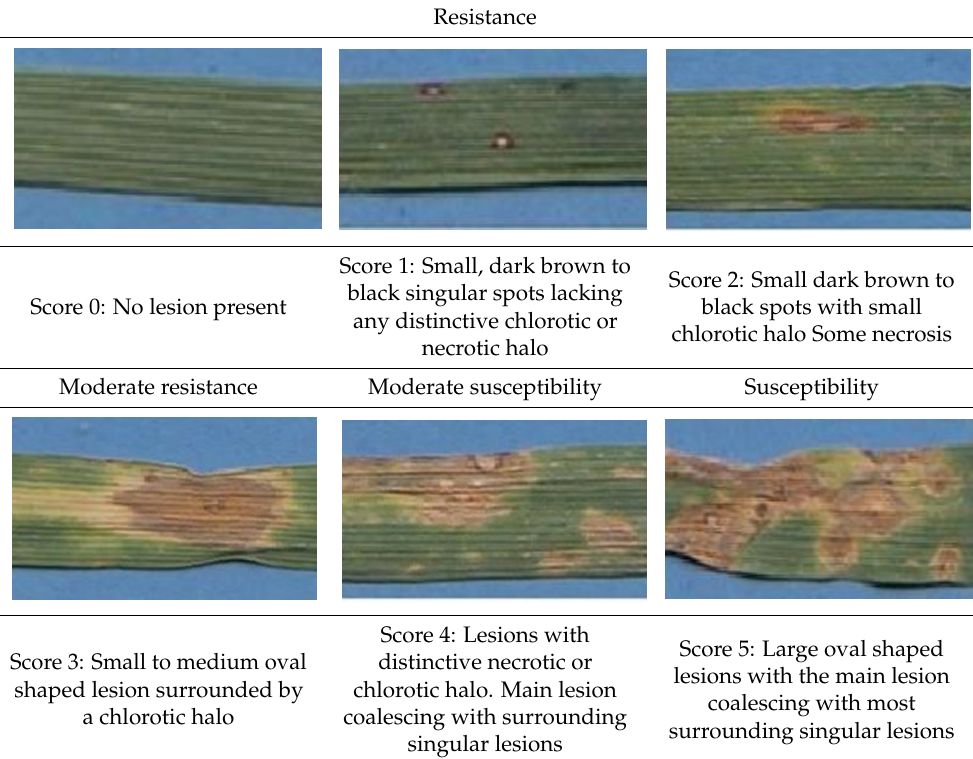
Table 1. Disease score (0–5 scale) based on lesion appearance used to assess the severity of Pyrenophora Table 1. Disease score (0 – 5 scale) based on lesion appearance used to assess the severity of Pyre- Table 1. Disease score (0 – 5 scale) based on lesion appearance used to assess the severity of Pyre- tritici-repentis lesions. Table 1. Disease score (0 – 5 scale) based on lesion appearance used to assess the severity of Pyre- Table 1. Disease score (0 – 5 scale) based on lesion appearance used to assess the severity of Pyre- nophora tritici-repentis lesions. nophora tritici-repentis lesions. nophora tritici-repentis lesions. nophora tritici-repentis lesions.